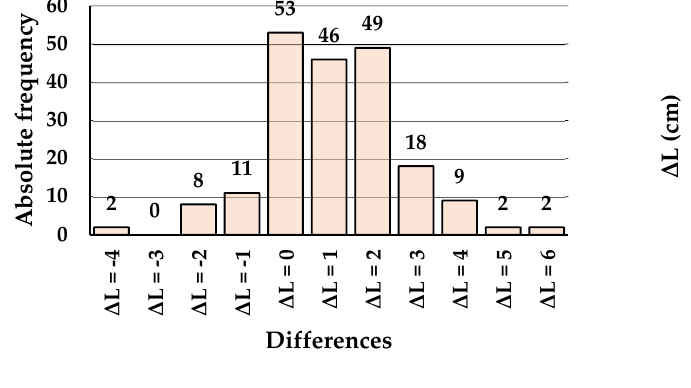
Figure 14. Relation between the lengths measured by the two methods (E2). Legend: red dashed line stands for perfect agreement and green dashed line stands for the dependence relation between Lmeas and Lman fitted by RTO.